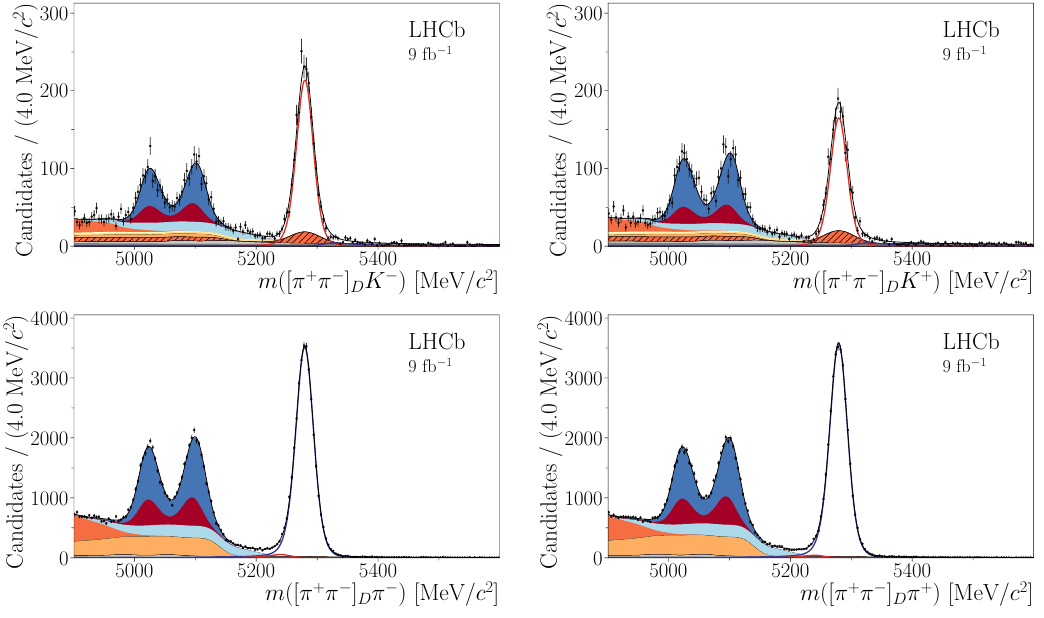
Figure 5 . Invariant-mass distribution of B ± → [ π + π − ] D h ± candidates with the fit result overlaid. A legend is provided in figure